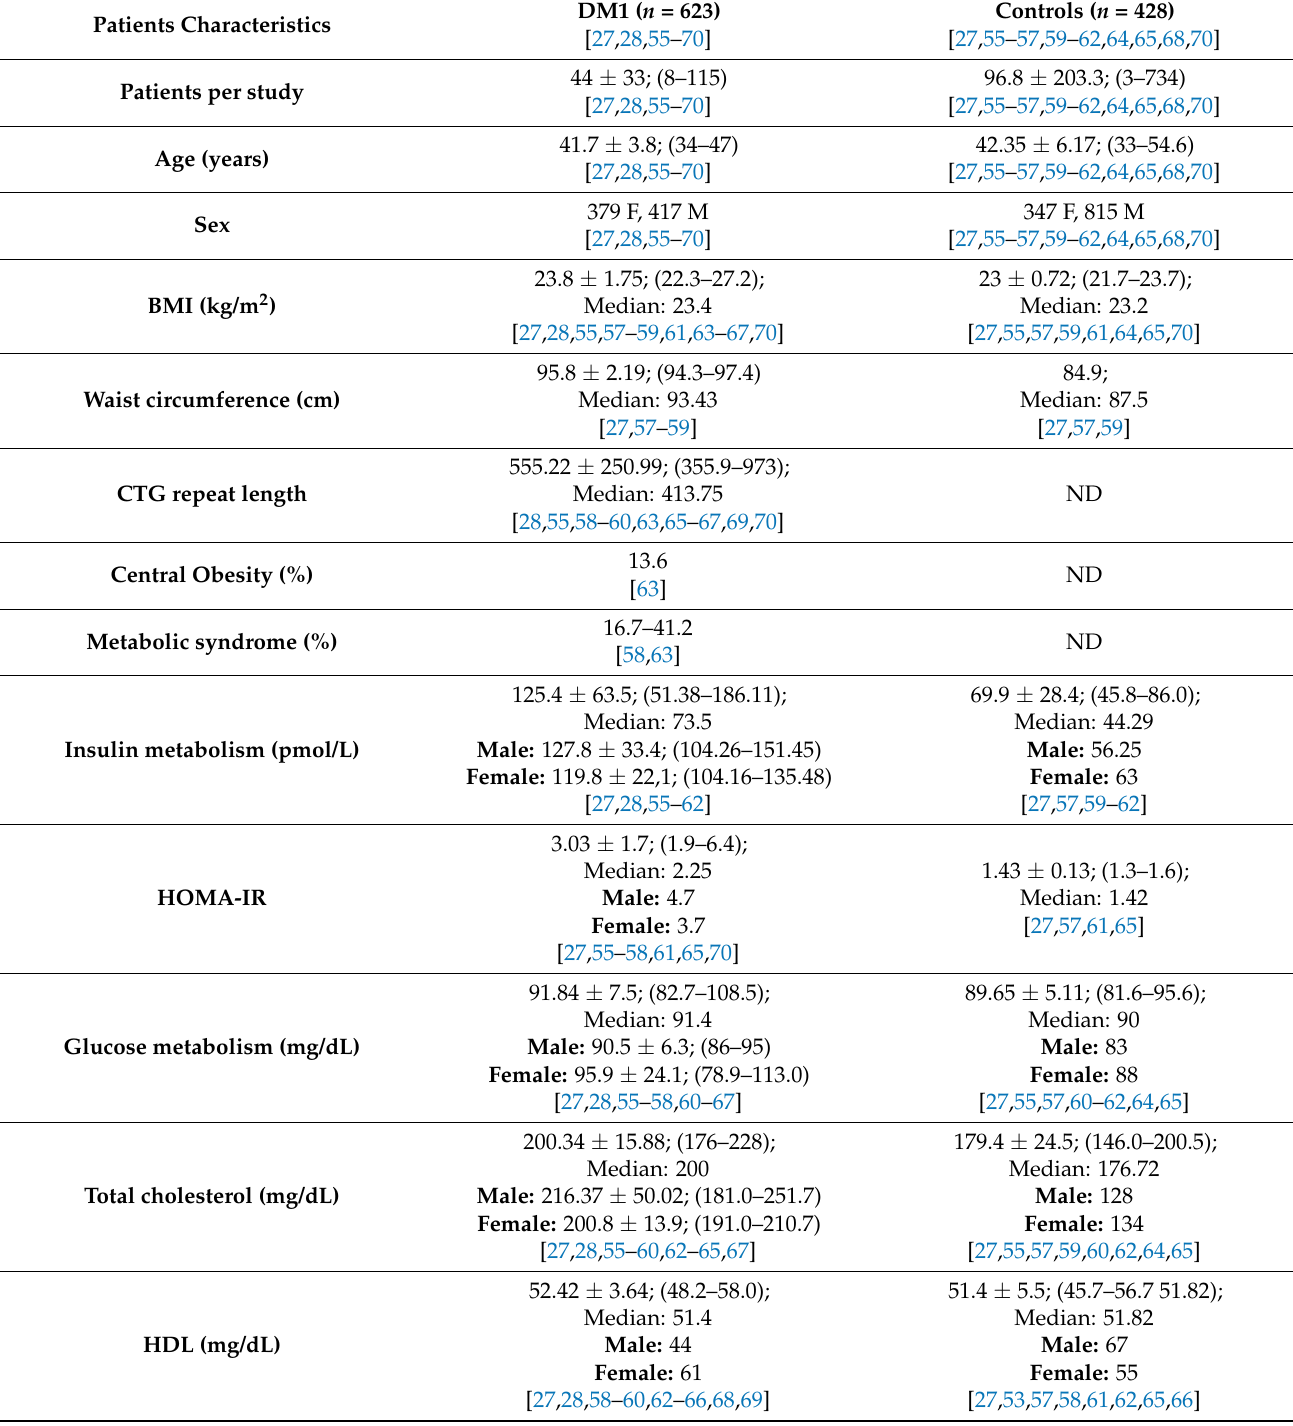
Table 2. Summary of previously reported data concerning abnormal metabolism in patients with DM1. Patients